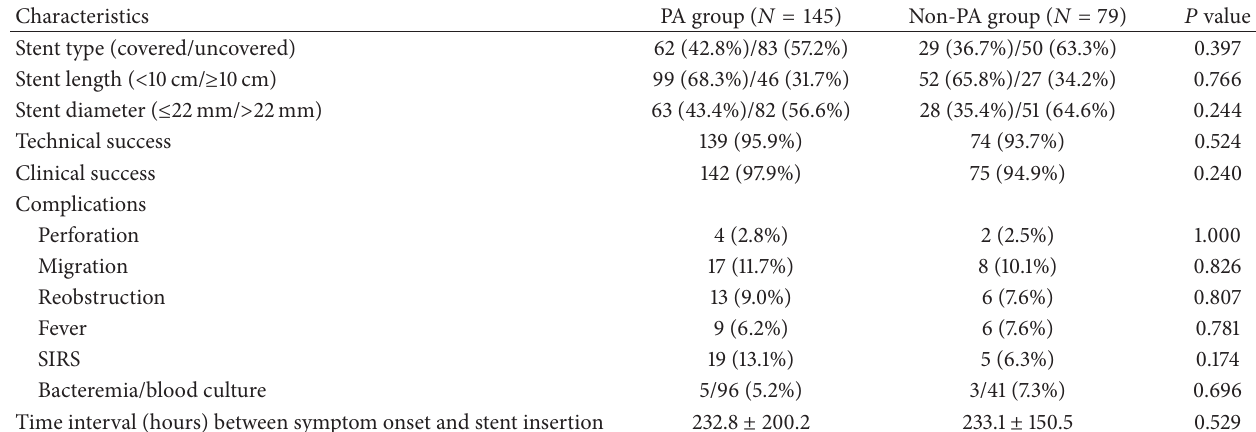
Table 2: Comparison of procedure-related outcomes in PA versus Non-PA